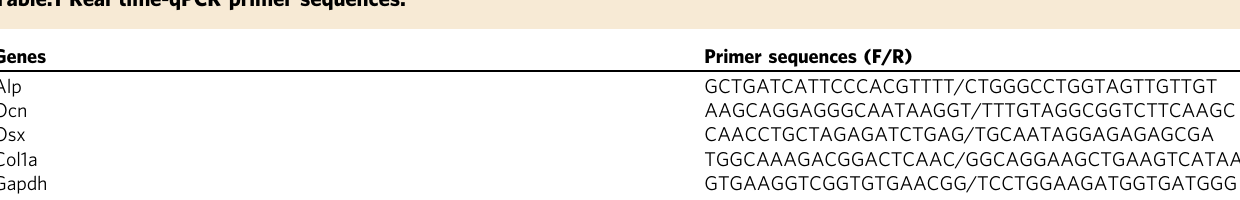
Table.1 Real time-qPCR primer